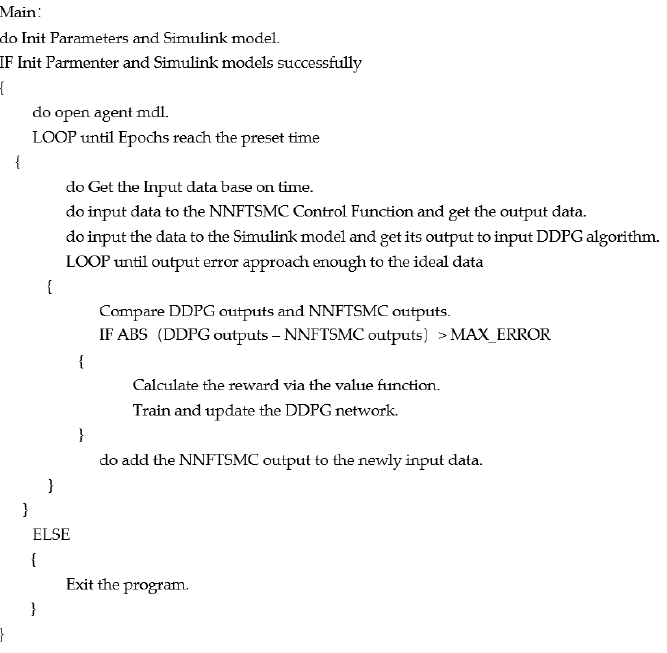
Figure 3. Pseudo-code of the proposed algorithm.